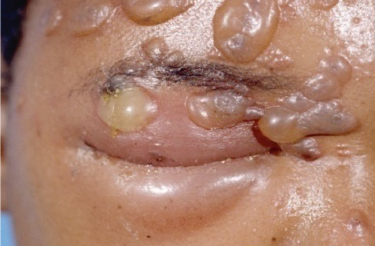
Figure 1. Vesiculobullous dermatitis of Herpes Zoster Ophthalmicus (Photo Courtesy of Dr Linda